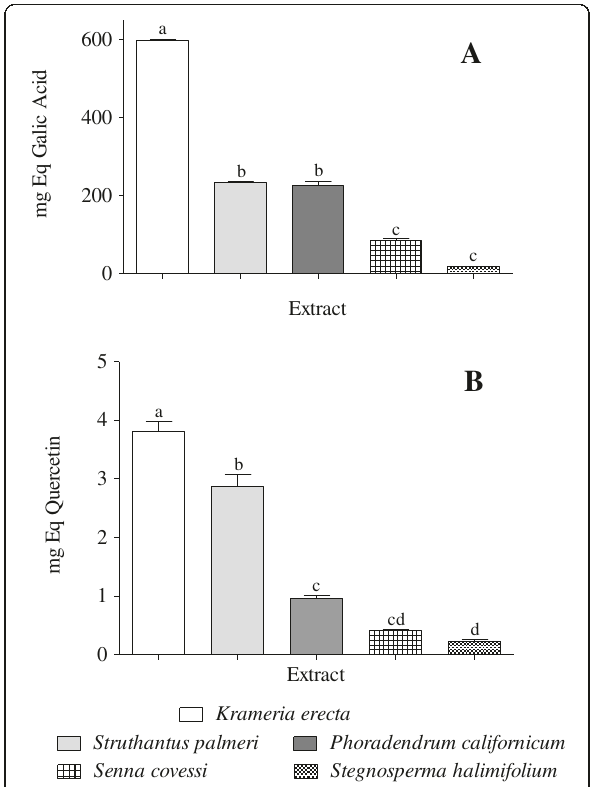
Figure 3 A) Total phenols content (expressed as mg Eq of galic acid), B) total flavonoids content (expressed as mg Eq of